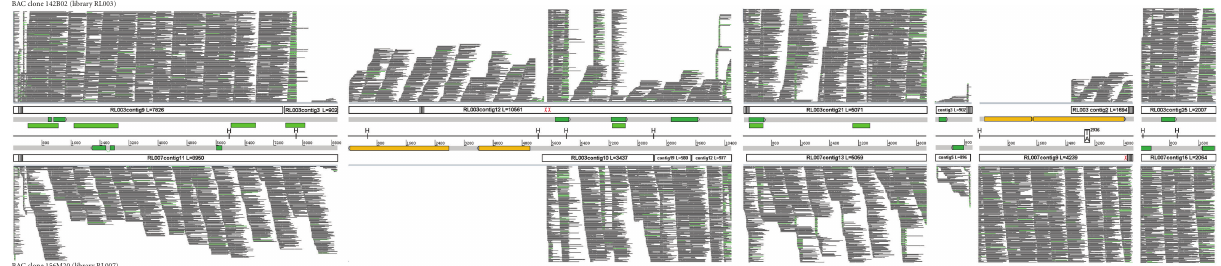
Figure 3: Comparison of haplotypes between assembled full BAC insert sequences of clones 142B02 and 156M20. Homologous regions are aligned and representative read depths are indicated above for 142B02 and below for 156M20. Annotated genes (dark green), expressed sequence tag (EST; light green), and repetitive element sequences (orange) are indicated. Microsatellite repeat motifs are shown as ( ||||